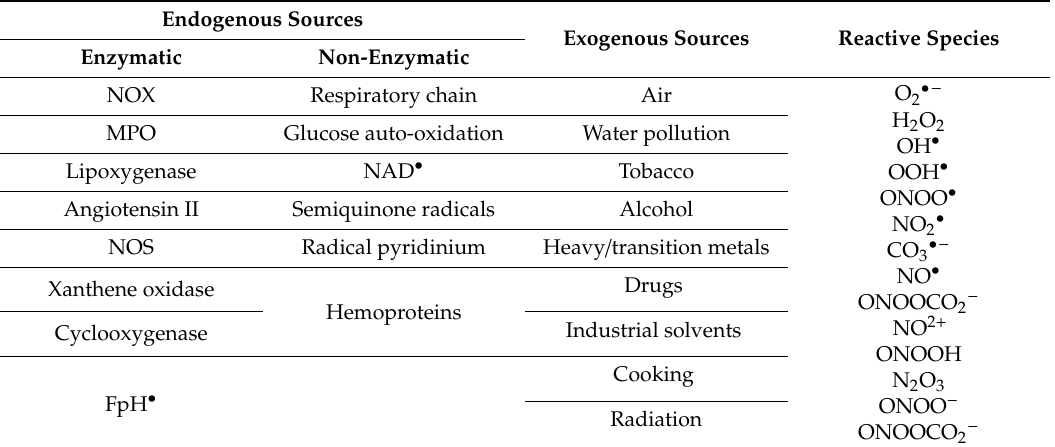
Table 2. Endogenous and exogenous sources of RONS and possible ROS and reactive nitrogen species (RNS).